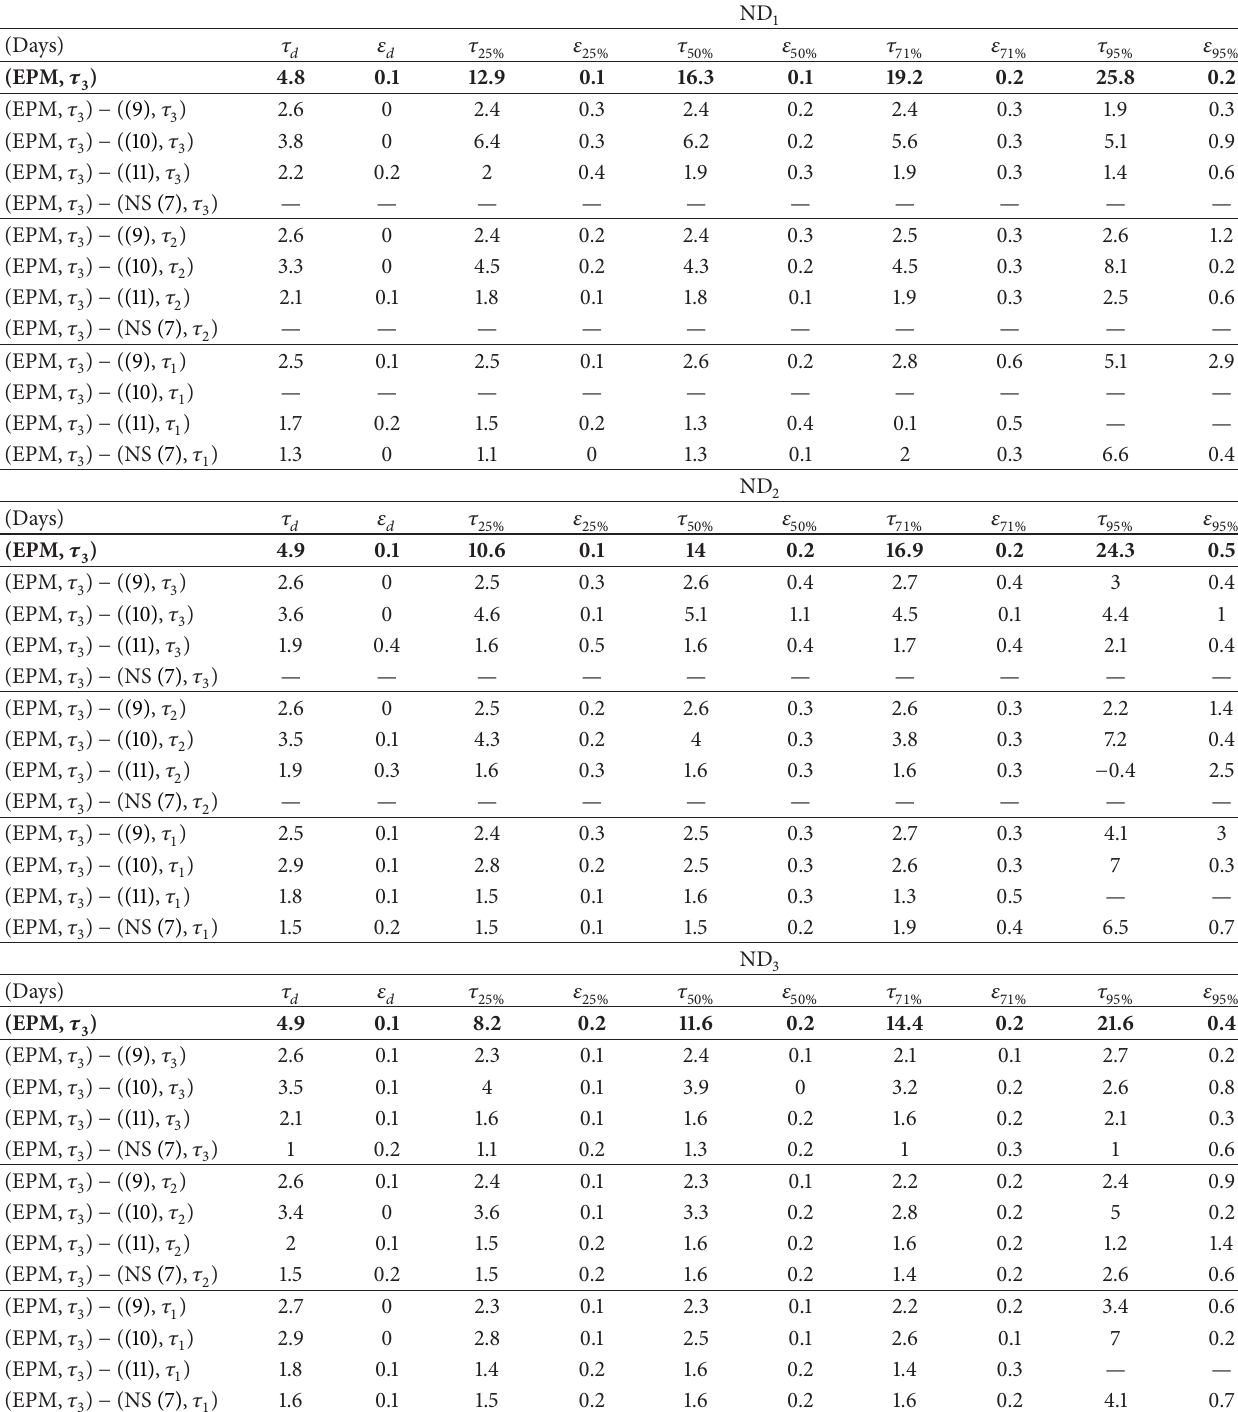
Table 1: Average values over 𝑀 1,...,5 of time limits (in days) for model values (EPM), for normal distributions ND 1,...,3 , and for prediction time length 𝜏 3 (bold rows). Difference between this model values and average values over 𝑀 1,...,5 received from (9)–(11) and NS (7) with parameters a , b , c , g, 𝑎 𝑚 , 𝑏 𝑚 , 𝑠 𝑚 , 𝑐 𝑚 , 𝑔 𝑚 , and 𝑙 𝑚 calculated from approximations of (4)–(7) for 𝜏 1 , 𝜏 2 , 𝜏 3 , and 𝑀 1,...,5 (columns 𝜏 𝑑 , 𝜏 25 % , 𝜏 50 % , 𝜏 71 % , 𝜏 95 %